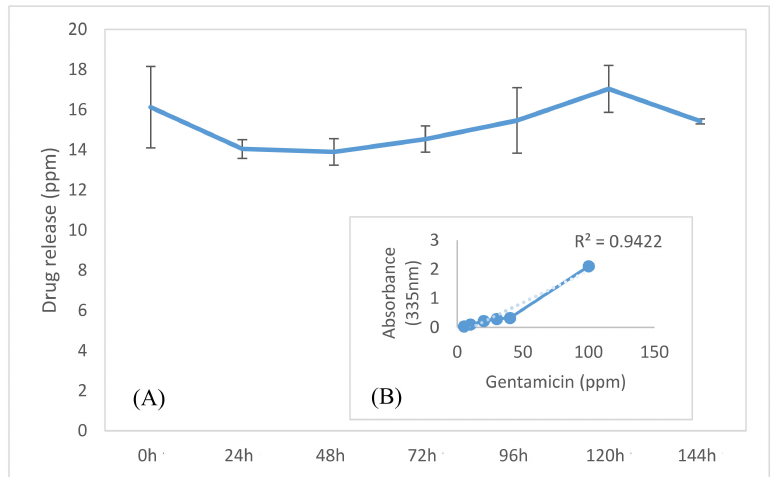
Figure 12. ( A ) Gentamicin release from CS-ZnHNTs-GS coatings (ppm). A gradual burst of drug release was observed, which could be due to drug adsorption on the mHNTs’ outer surface and chitosan coating. ( B —gentamicin standard XRF curve.) ( n =